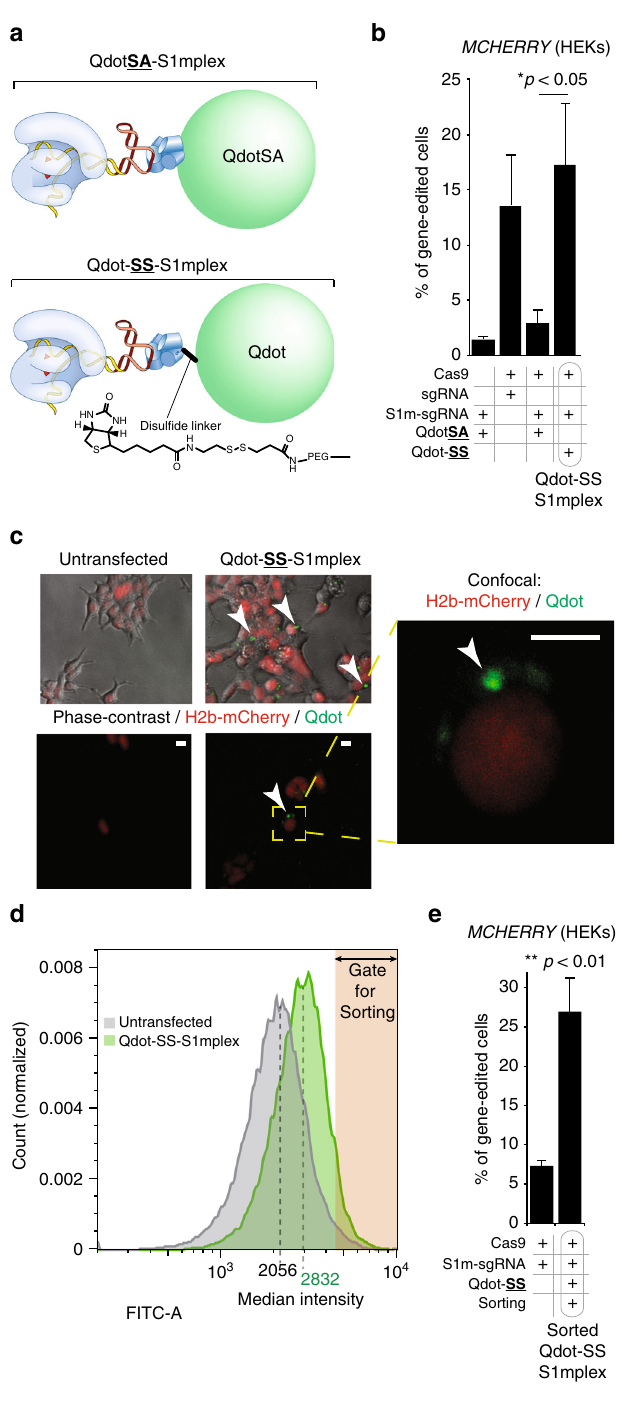
Fig. 5 Addition of Qdots with degradable linkers to identify S1mplex- positive cells. a Schematic of S1mplexes with quantum dot cargoes. Qdots can be complexed with the S1mplex by streptavidin covalently-attached directly to the quantum dot (QdotSA-S1mplex, top), or a enzymatically- cleavable disul fi de linker (Qdot-SS-S1mplex, top). The quantum dot has a mean diameter of 20 nm. b Gene-editing comparison of different Qdot- S1mplexes. Gene editing of HEK H2B-mCherry reporter cells 5 days post sorting as assayed by fl ow cytometry. DSBs within MCHERRY transgene repaired by NHEJ will generate indels near the fl uorophore resulting in a loss of fl uorescence. Percent gene editing refers to percent of cells without mCherry fl uorescence. QdotSA interferes with RNP activity, while Qdot-SS has equivalent gene-editing activity as the free RNP (* p < 0.05, Student ’ s two-tailed t test, error bars ± 1 s.d., n = 3 technical replicates). c Representative epi fl uorescence and confocal images of untransfected and Qdot-SS-S1mplex transfected cells 24 h post transfection (scale bar: 10 µ m). Arrowheads indicate Qdot fl uorescence in the cytoplasm. d Increased fl uorescence of Qdot-S1mplex (green) allows sorting out of quantum dot positive fractions compared to untransfected cells (grey) 24 h post transfection. e Quantum dot conjugation to S1mplex via a cleavable disul fi de linker allows fl uorescent enrichment of gene-edited human